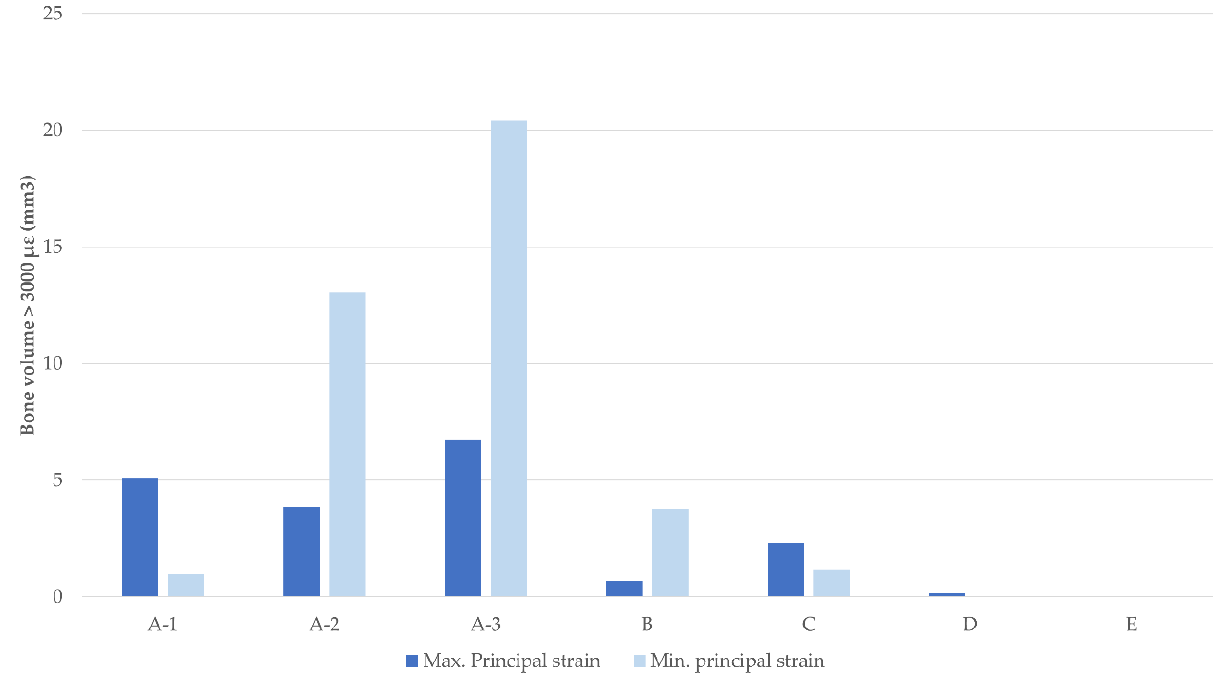
Figure 8. Bone volume with a strain level > 3000 µε for each scenario (mm 3 ).